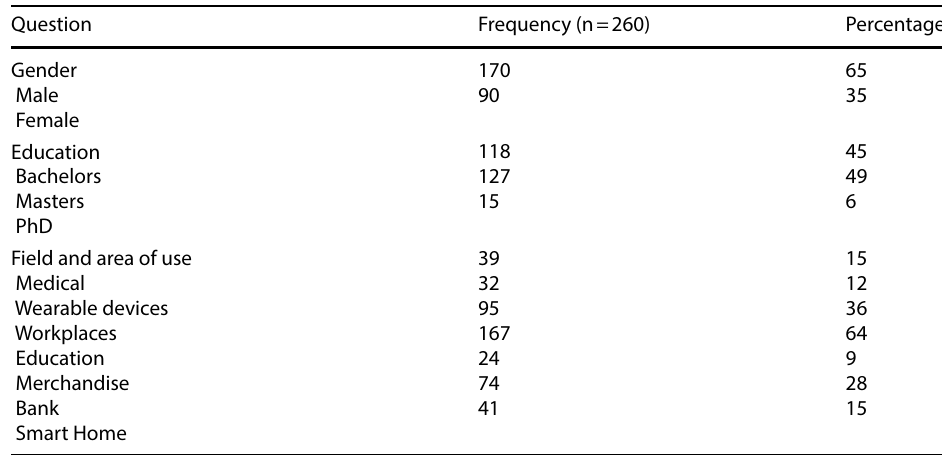
Table 1 Profile of the